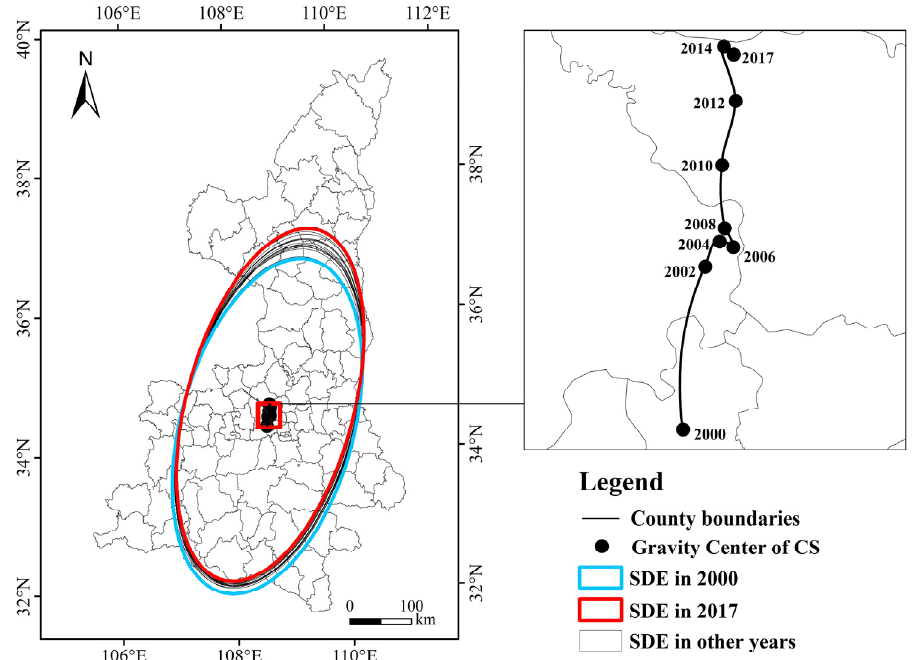
Figure 4. SDE and center-of-gravity migration path.